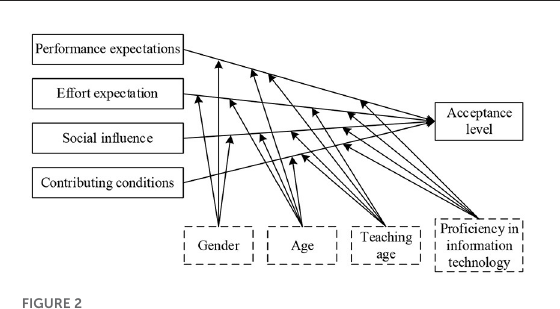
FIGURE2 Theoretical model of factors influencing teachers’ acceptance of robotics